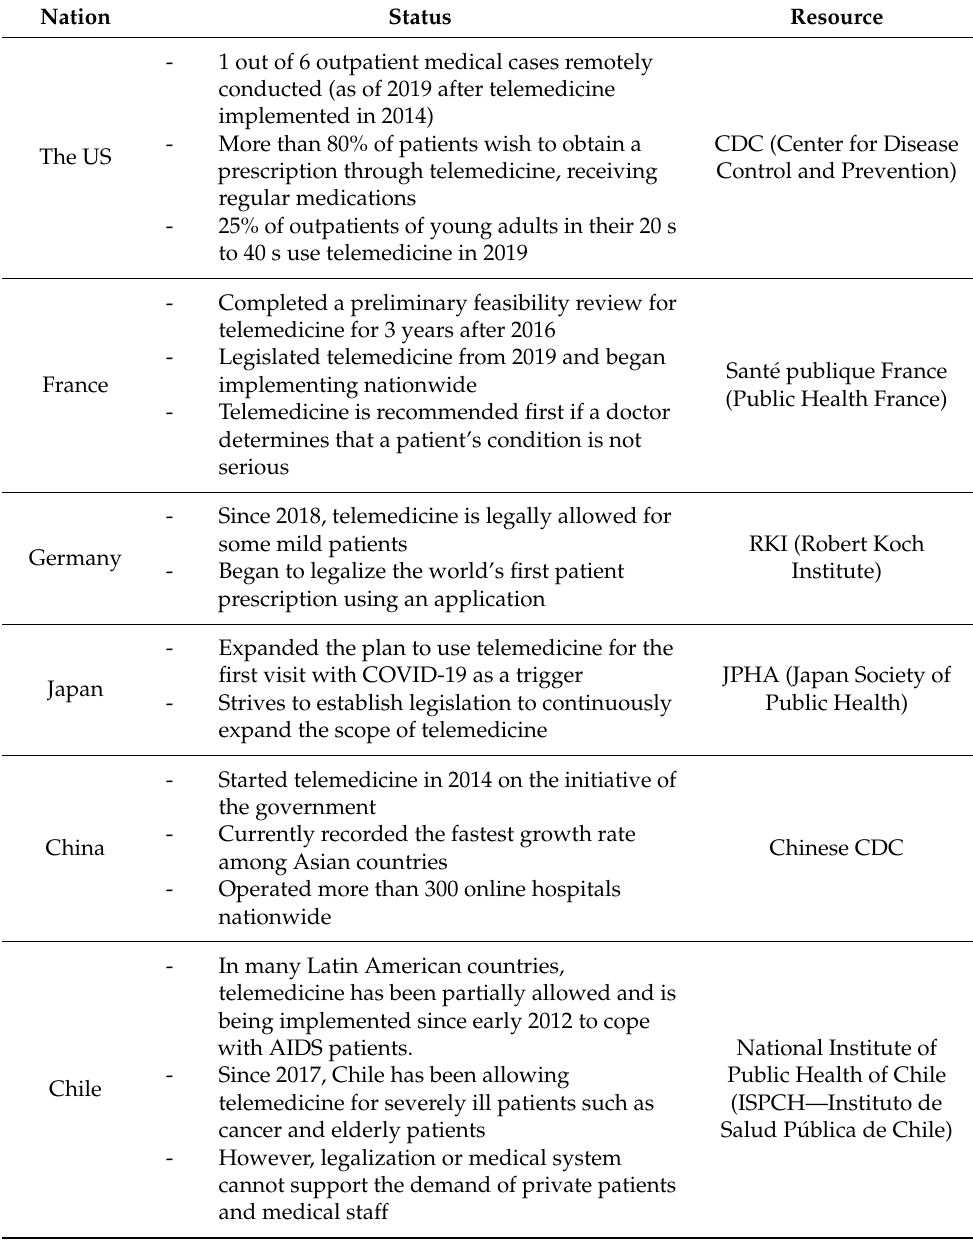
Table 1. Introduction of telemedicine in major